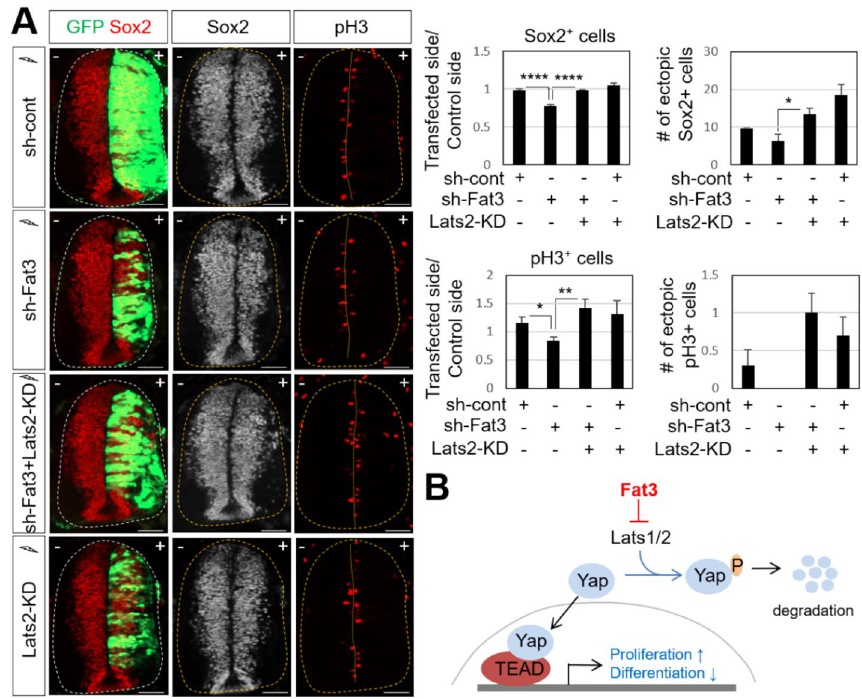
Figure 6. Overexpression of Lats2-KD rescues the proliferation defect caused by Fat3 knockdown. ( A ) In ovo electroporation of Myc-Lats2-KD together with sh-Fat3 was performed at HH13, followed by immunostaining analyses with indicated antibodies for chick embryos (thoracic level). +, electroporated side. GFP expression indicates transfected cells. Quantifications of Sox2 + and pH3 + cells in the electroporated side (+) relative to those in the unelectroporated control side (−) and the number of ectopic Sox2 + and pH3 + cells in the electroporated side were shown. Quantification was performed with 9–10 images from 4 to 6 embryos of each test set. Values are means ± sem. Statistical difference was determined by one-way ANOVA followed by Turkey’s test using Prism 9 (GraphPad) software; *p < 0.05, ****p < 0.0001. Scale bars: 100 μm. ( B ) Working model. Fat3 promotes cell proliferation and limits neurogenesis through enhancing Yap transcriptional activity. The